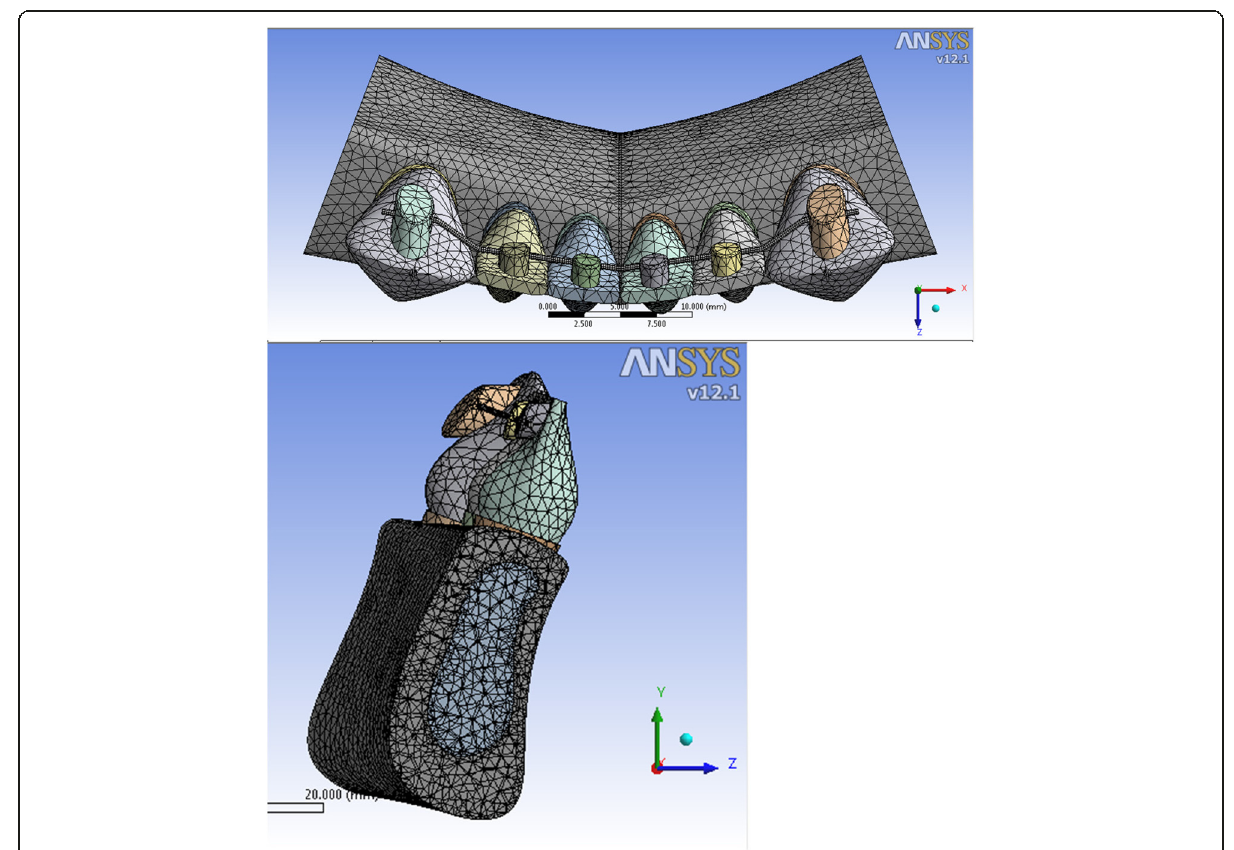
Fig. 4 Meshed model 4 showing the inclination of the anterior teeth at 110° to the horizontal plane